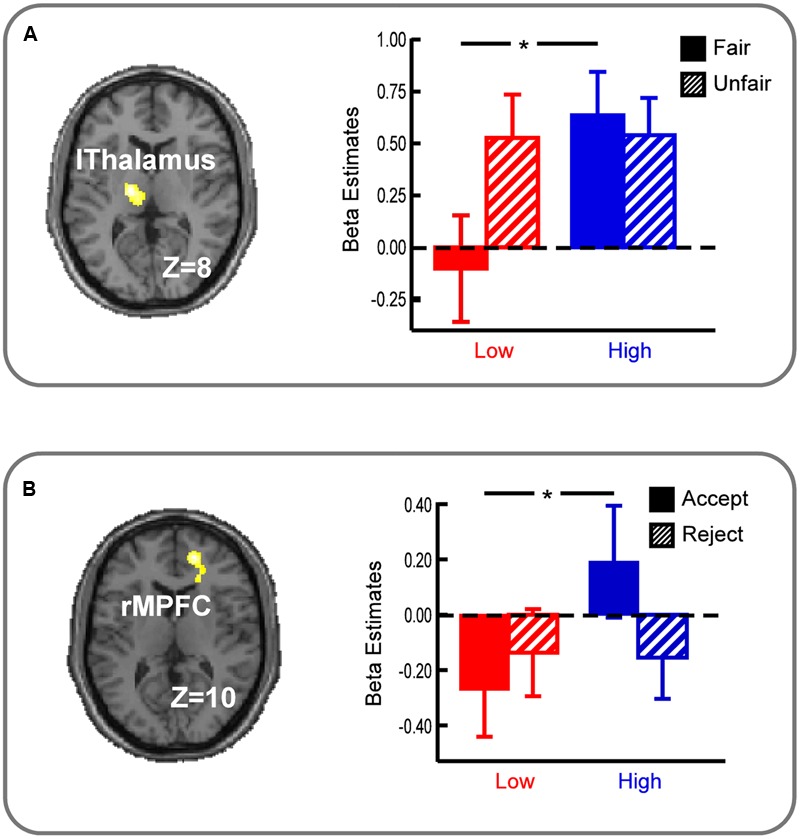
(A) Left Thalamus showed the modulation of economic status on perception of unfairness. (B) Right MPFC showed the modulation of economic status on responses to unfair offers. l, left hemisphere; r, right hemisphere. All the activations survived the voxel-level threshold of uncorrected p < 0.001 with the cluster-level threshold of Family wise error (FWE) corrected p < 0.05. Error bars indicate SEM. ∗p < 0.01.